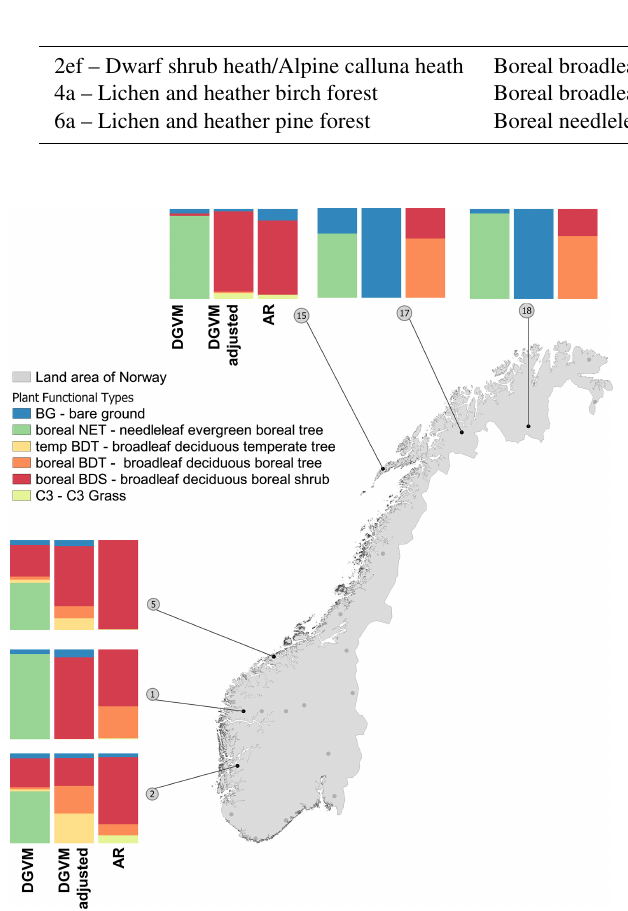
Figure 4. PFT profiles for the subset of six plots subjected to sensi- tivity experiments with new DGVM establishment thresholds. The columns in each cluster of the three bar charts represent, from left to right, the dynamic global vegetation model (DGVM) with original (default) parameter settings, DGVM with revised parameter settings and AR reference dataset. For further details, see Table